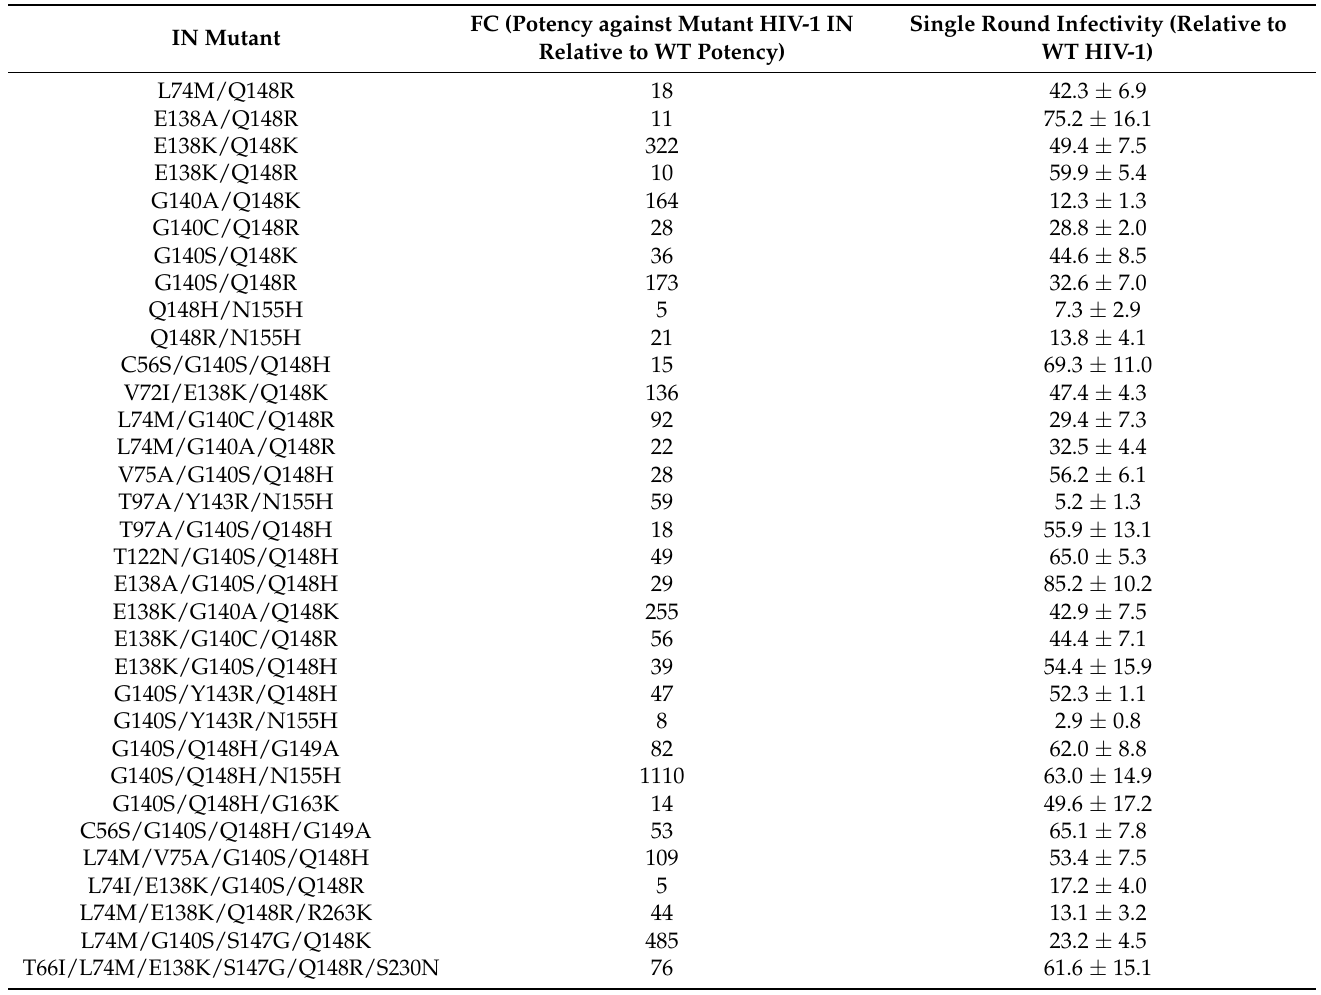
Table 5. IN mutants selected against CAB. IN double and complex mutants that have been selected by CAB in vitro or identified in IN susceptibility assays are listed. The FCs of the potencies of CAB against the IN mutant relative to its potency against WT HIV-1 are shown, as is the single round infectivity of the IN mutant relative to WT HIV-1. IN